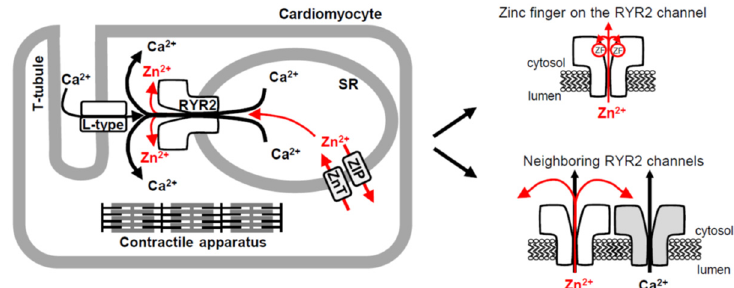
Figure 8. The RYR2 channel provides a novel pathway for rapid Zn 2+ transport in cardiomyocytes. Schematic illustrating three pathways (one novel) for Zn 2+ transport across the cardiac SR mem- brane. Two Zn 2+ transporter protein families, ZIP and ZnT, play an essential role in cardiac Zn 2+ homeostasis and mediate a slow-rate transport. In the heart, Zn 2+ release through the RYR2 channel, accompanying a robust Ca 2+ release triggered by small Ca 2+ entry through the L-type Ca 2+ channel, could also contribute to global and/or local Zn 2+ signaling which requires a fast-rate transport. At the local scale, the Zn 2+ current flowing through the RYR2 channel might target its intrinsic Zn 2+ finger situated within the C-terminal tail of all four RYR2 subunits. In addition, the RYR2 channel (colored gray) might be stimulated by Zn 2+ cations emanating from the neighboring RYR2 channel (colored white). Arrows indicate the direction of Zn 2+ (red) and Ca 2+ (black) mobilization.